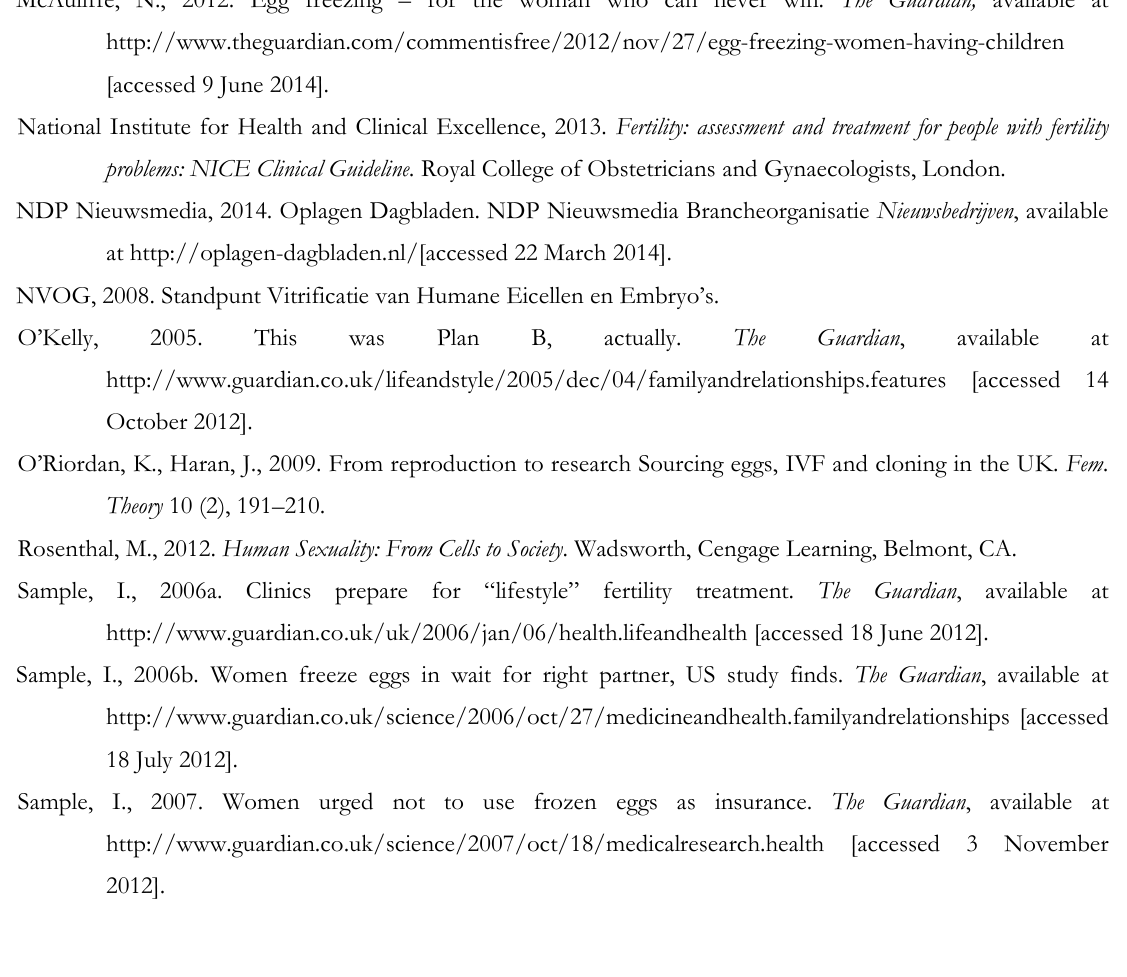
Lucy van de Wiel, For Whom The Clock Ticks: Reproductive Ageing and Egg Freezing in Dutch and British News Media Studies in the Maternal , 6(1), 2014,